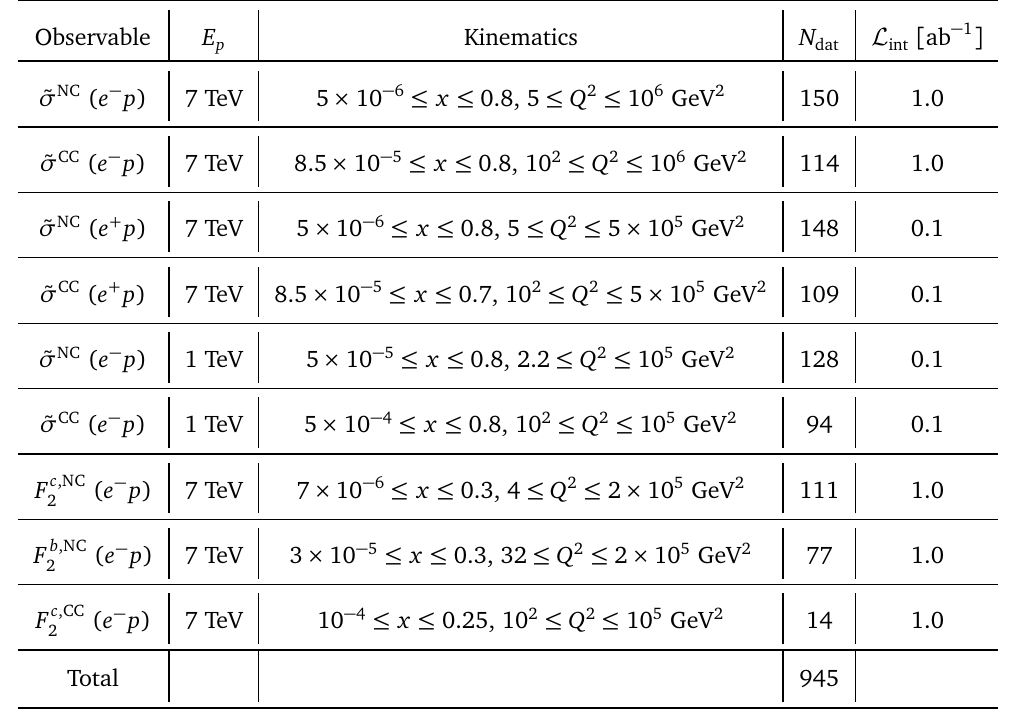
Table 2.1: Overview of the main features of the LHeC pseudo–data [ 26,27 ] included in our PDF projections. For each process, we indicate the kinematic coverage, the integrated luminosity, the proton energy, and the number of pseudo–data points, N , after the Q ≥ 2 GeV kinematic cut. Note that in all cases the incoming lepton dat = 60 GeV. We ignore the effect of the incoming lepton beam energy is fixed to be E l